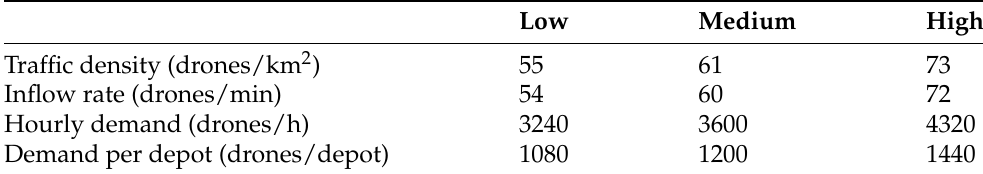
Table 3. Traffic density characteristics of the three demand scenarios for the simulation area of Manhattan, New York City, network consisting of an area of 59.1 km 2